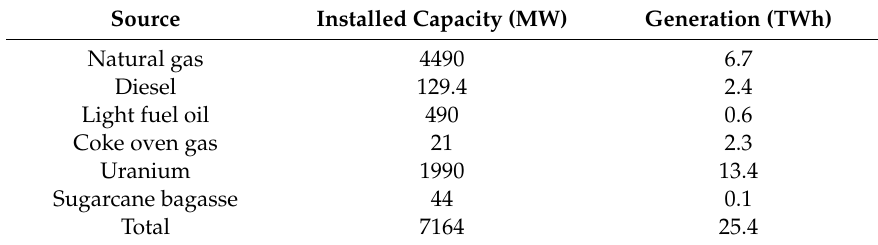
Table 1. Rio de Janeiro state’s thermoelectric installed capacity and generation—2016. Source: [22].